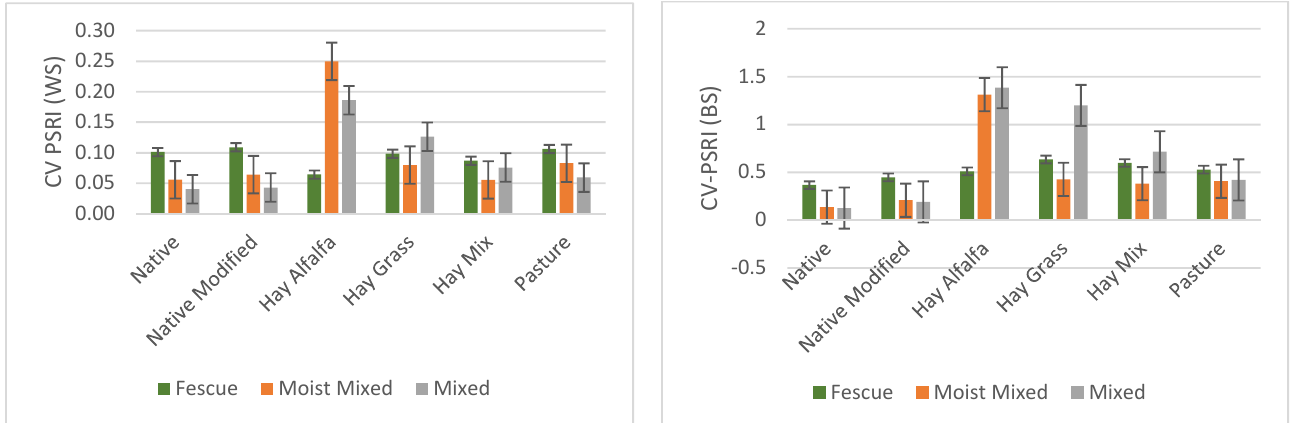
Figure 8. The within-sites (WS) and between-sites (BS) PSRI coefficient of variation (CV) for six land cover types located at three ecoregions.